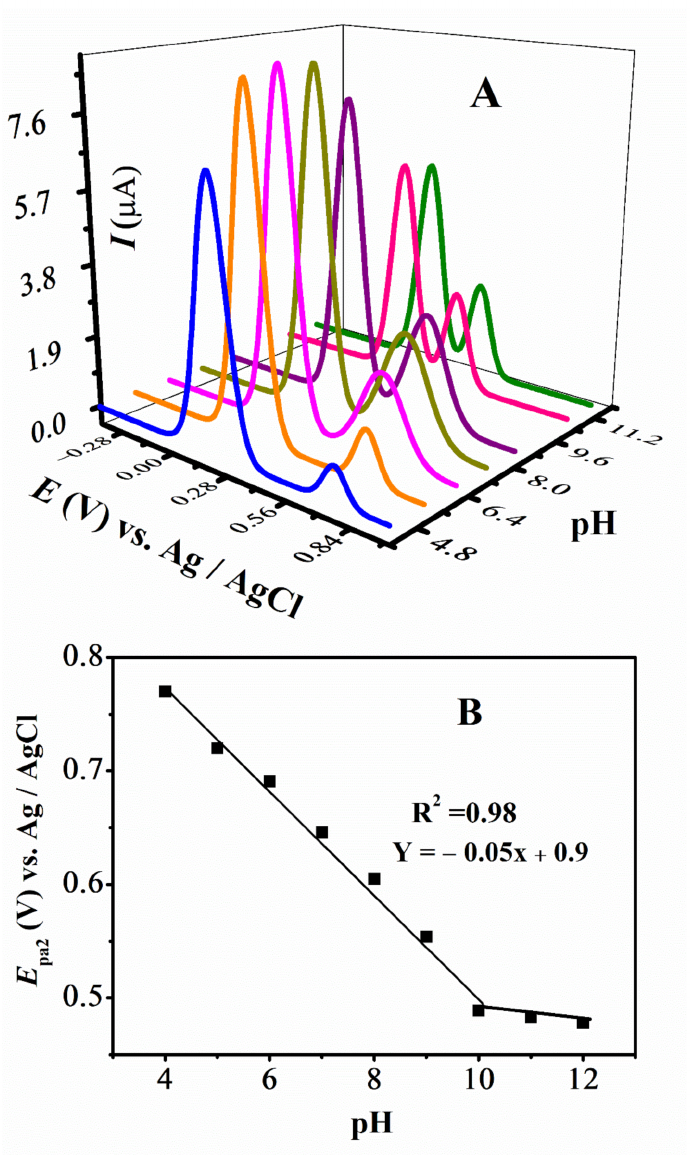
Figure 6. ( A ) DPVs obtained at 0.1 V/s in different pH media and ( B ) plot of E pa vs. pH of